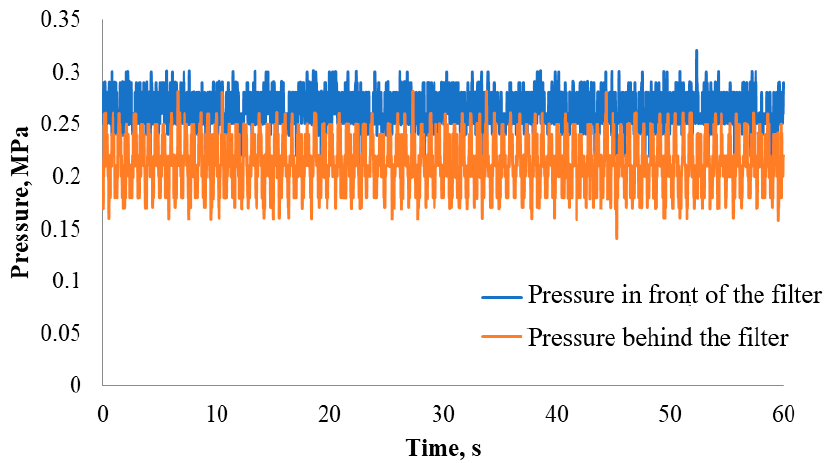
Figure 8. Plot of flow of contaminated oil with MANN W950/26 filter at 30 °C.